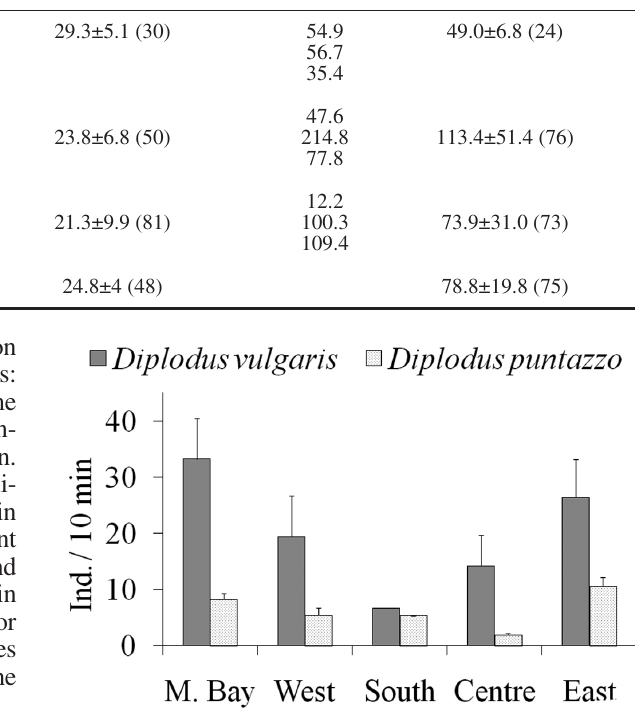
Fig . 3. – Mean density of Diplodus settlers (ind./10 min census) for each zone and species; error bars: standard error